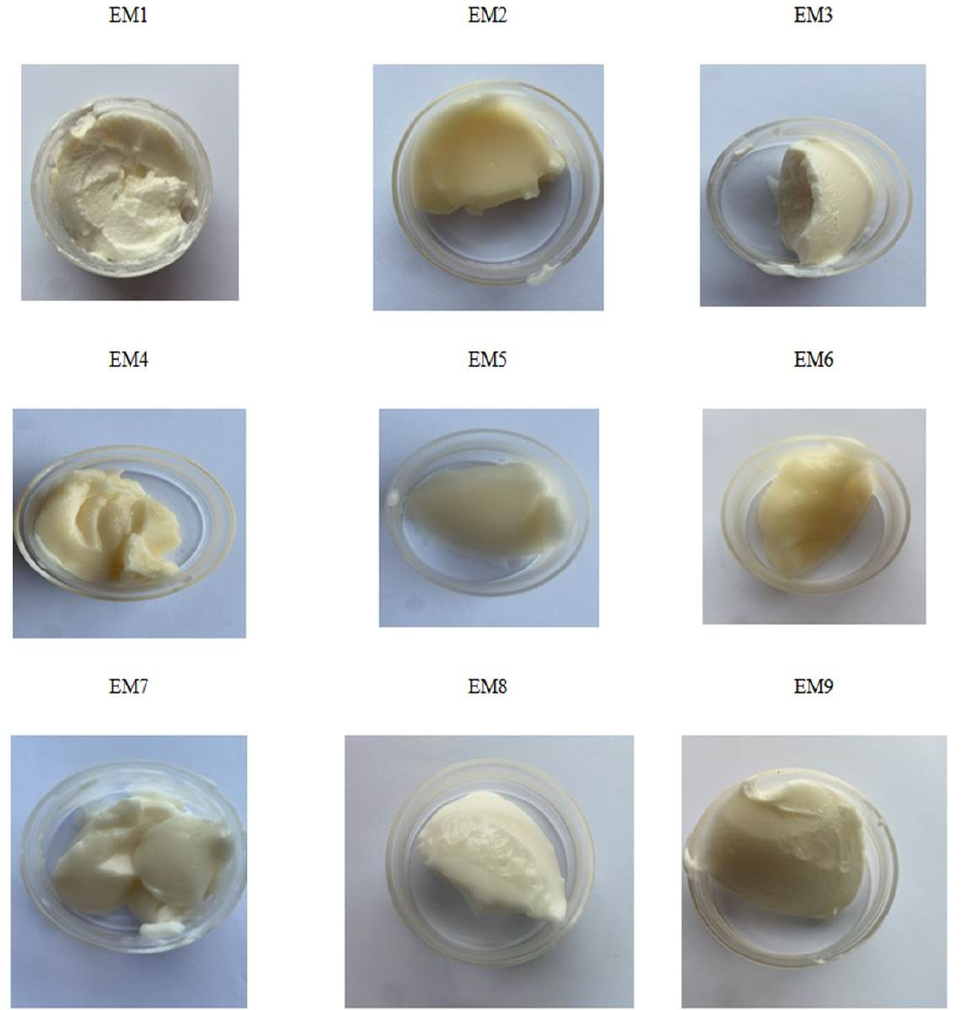
Figure 4. Appearance and macroscopic properties of the emulsions obtained from shellac wax-based oleogels.